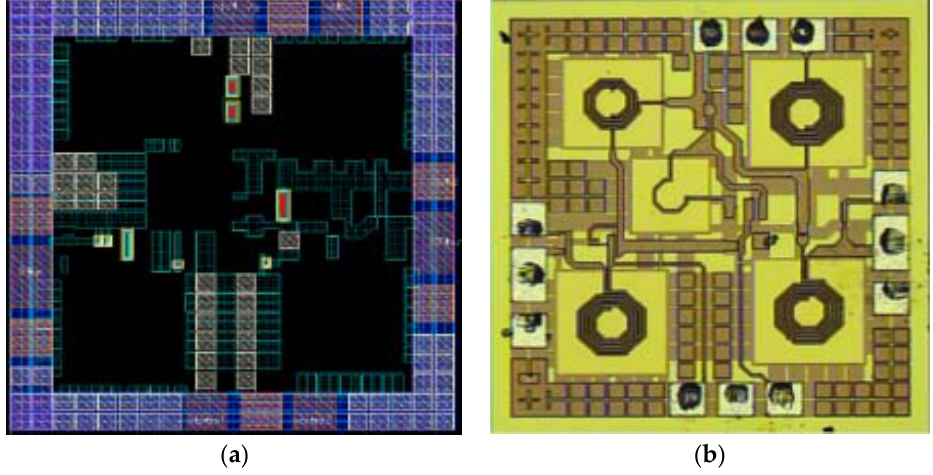
Figure 42. Split fabrication of a Class AB RF power amplification circuit ( a ) before metallization at a untrusted foundry and ( b ) after metallization at a trusted